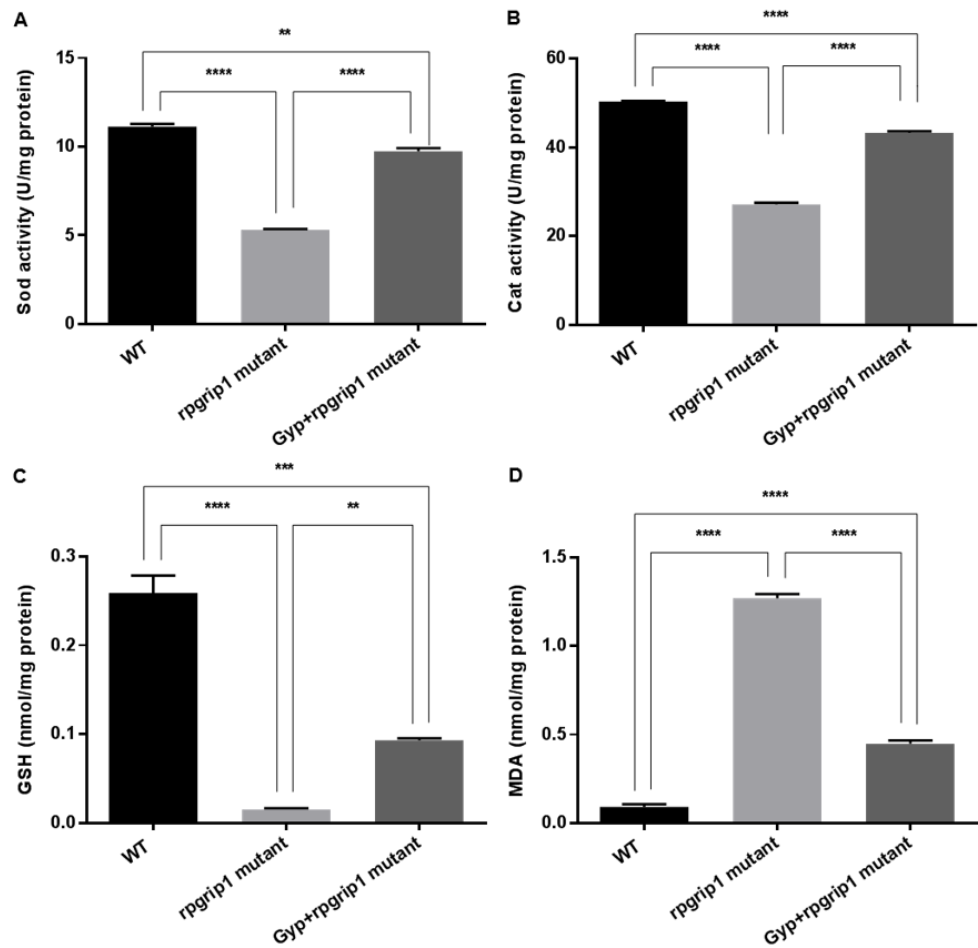
Figure 5. Sod ( A ) and catalase ( B ) activities, and GSH level ( C ) were markedly increased but MDA level ( D ) was significantly decreased in Gyp-treated rpgrip1 mutant zebrafish eye samples. WT, wildtype zebrafish; UT, untreated rpgrip1 mutant zebrafish. Statistical comparisons between individual groups were carried out using one-way ANOVA followed by Bonferroni’s test. Data are displayed as mean ± SEM ( n = 6 animals of each group). ** p < 0.01, *** p < 0.001, **** p <